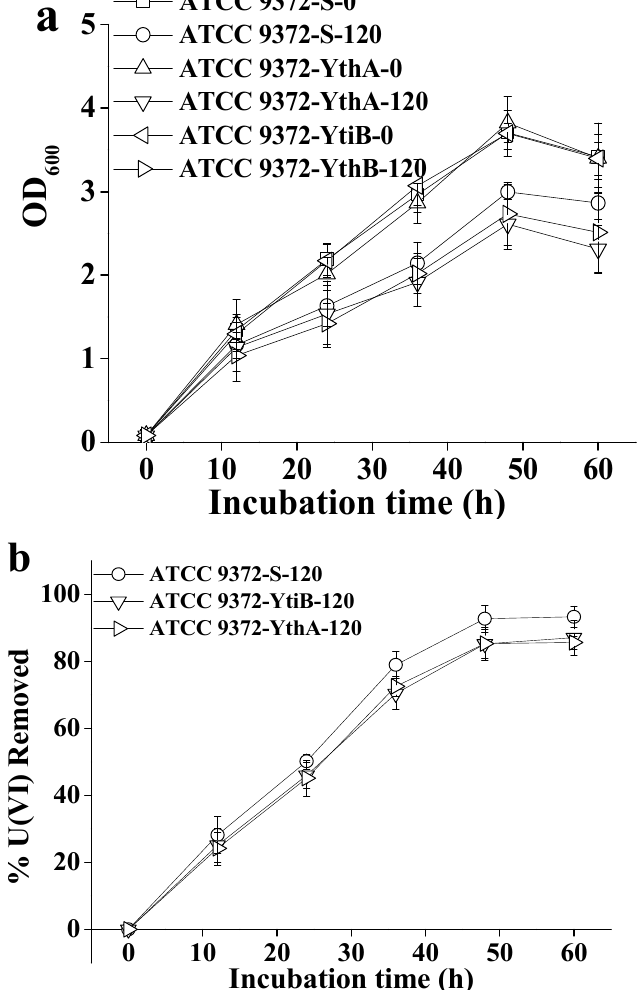
Figure 5. The growth rate ( a ) and U(VI) removal capacity ( b ) of transgenic ATCC 9372 strains in U(VI)-containing LB media. ATCC 9372-S-0—the ATCC 9372 strain transformed with the pBE-S DNA and grown in the media containing no U(VI); ATCC 9372-S-120—the ATCC 9372 strain transformed with the pBE-S DNA and grown in the media containing 120 mg L − 1 U(VI); ATCC 9372- yti B-0—the ATCC 9372 strain transformed with the yti B gene and grown in the media containing no U(VI); ATCC 9372- yti B-120—the ATCC 9372 strain transformed with the yti B gene and grown in media containing 120 mg L − 1 U(VI); ATCC 9372- yth A-0—the ATCC 9372 strain transformed with the yth A gene grown in the media containing no U(VI); ATCC 9372- yth A-120—the ATCC 9372 strain transformed with the yth A gene grown in media containing 120 mg L − 1 U(VI). All experiments were performed in triplicate. The average results for three experiments are shown; bars represent standard deviations between repeats.